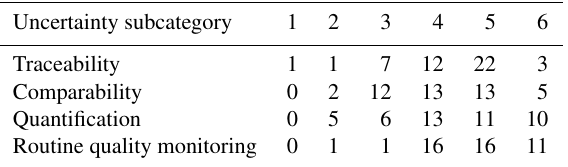
Table 4. Frequency of occurrence of the maturity matrix scores for the four subcategories (traceability, comparability, quantifica- tion and routine quality monitoring) of the main category, uncer- tainty.